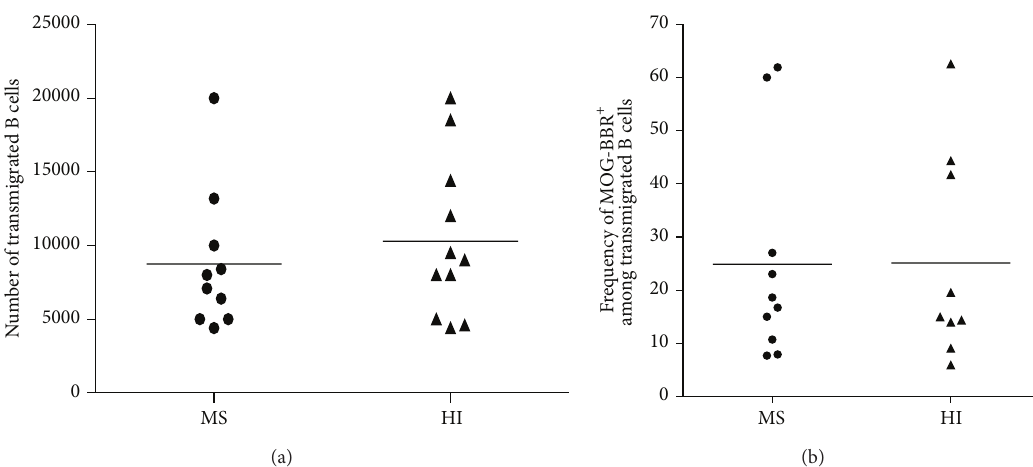
Figure 7: Transmigration of B cells across brain vessel derived endothelial cells. (a) B cells were negatively selected and a transmigration assay across HCMEC/D3 cell line was performed. Transmigrated cells in MS ( 𝑛 = 10 ) and HI ( 𝑛 = 11 ) were counted; no difference was observed (ns, 𝑃 > 0.05 , Mann-Whitney test ). (b) Transmigrated B cells were stained and incubated with MOG coated beads. The frequency of MOG-BBR was assessed in MS patients ( 𝑛 = 10 ) and HI ( 𝑛 = 9 ) (ns, 𝑃 > 0.05 , Mann-Whitney test